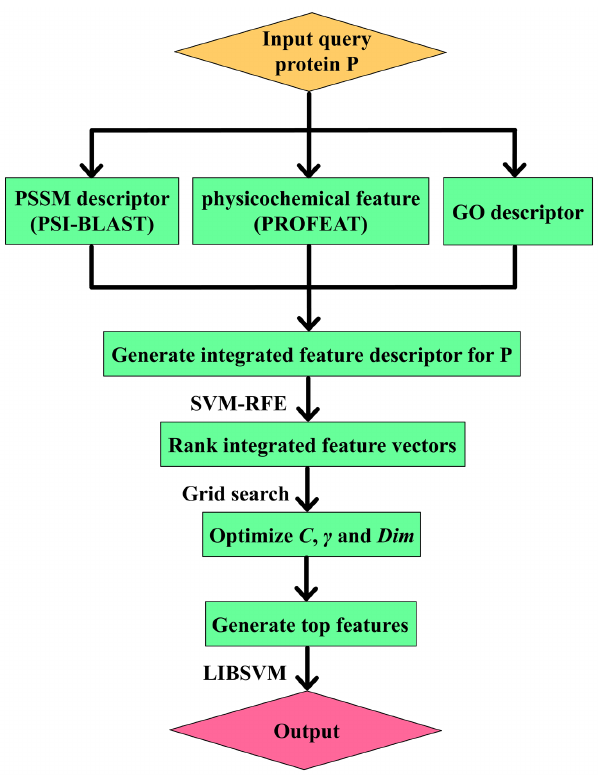
Figure 2. This graph shows the pipeline that goes from the query sequence to the final output as well as all intermediate steps.